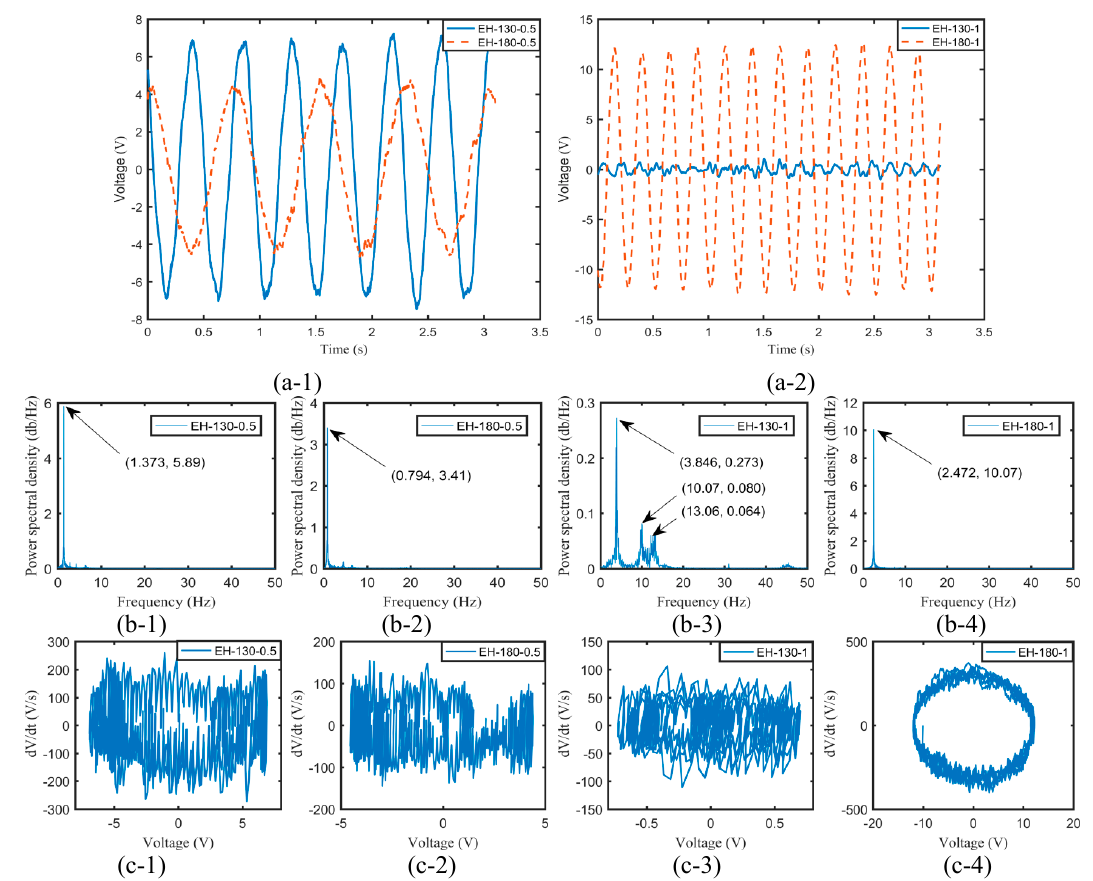
Figure 4. The time histories ( a ), the power spectral densities ( b ), and the phase portraits ( c ) of output voltages for various harvesters at 10.52 m / s.